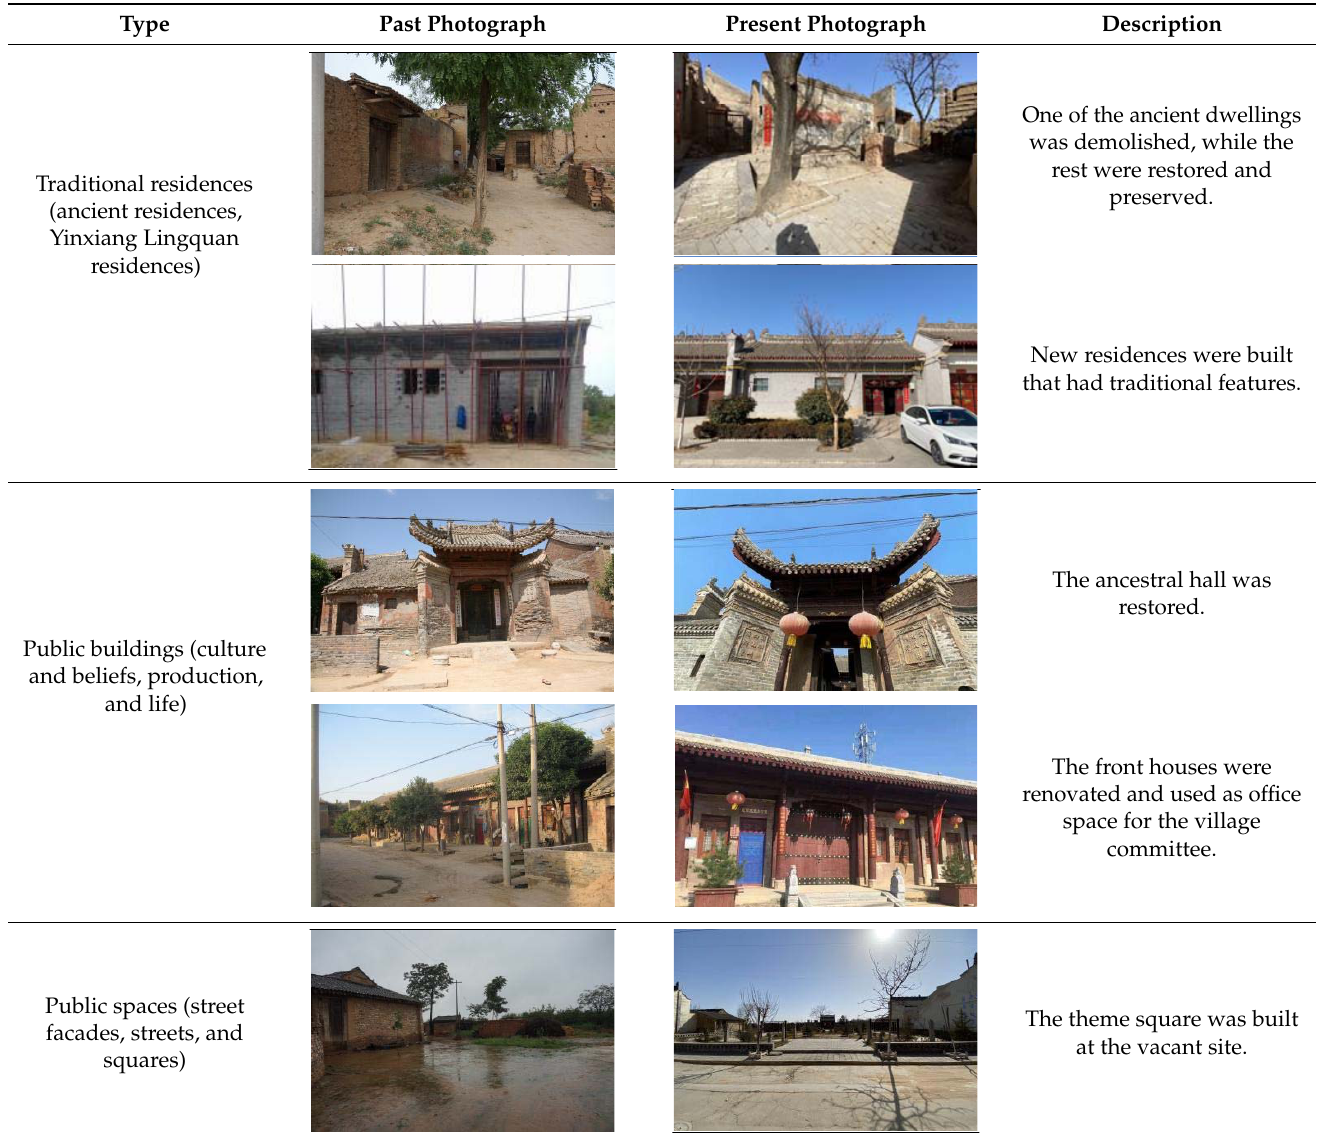
Table 4. Comparison of changes in features in Lingquan Village in the past and present (Source: authors).